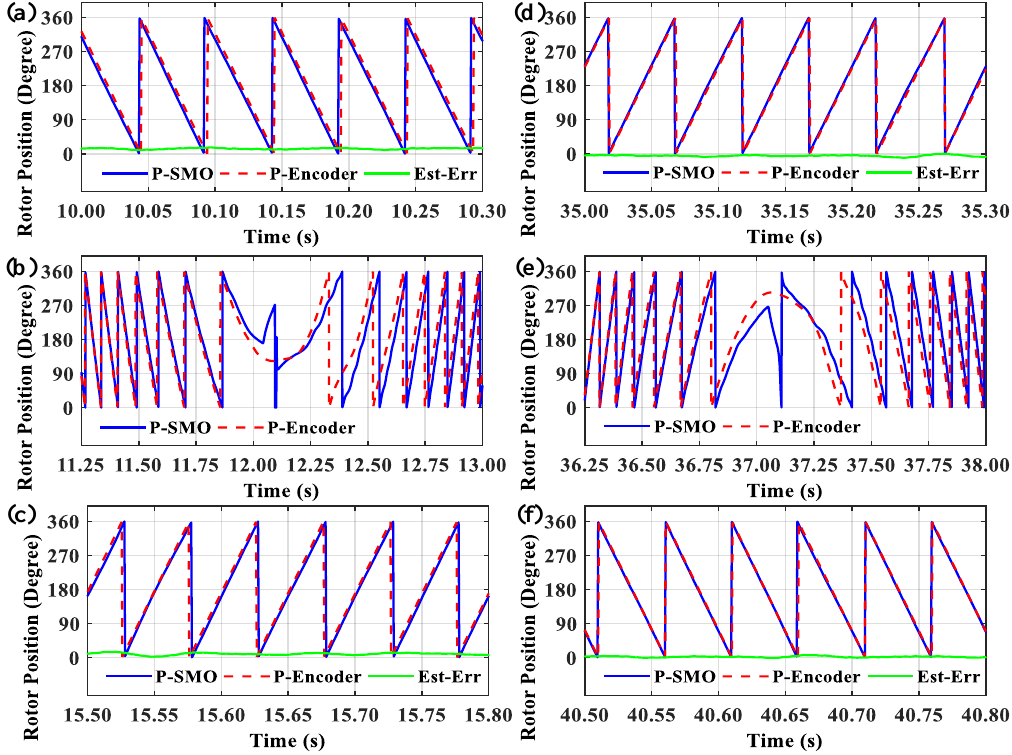
Figure 19. Experimental results of rotor position in the case of the varied rotational direction: from negative to positive ( a – c ); and from positive to negative ( d – f ).